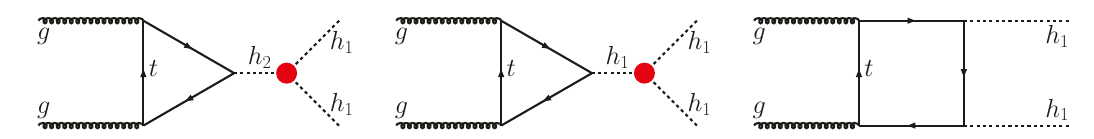
Figure 7 . Representative resonant (left) and non-resonant (middle and right) Feynman diagrams contributing to di-Higgs